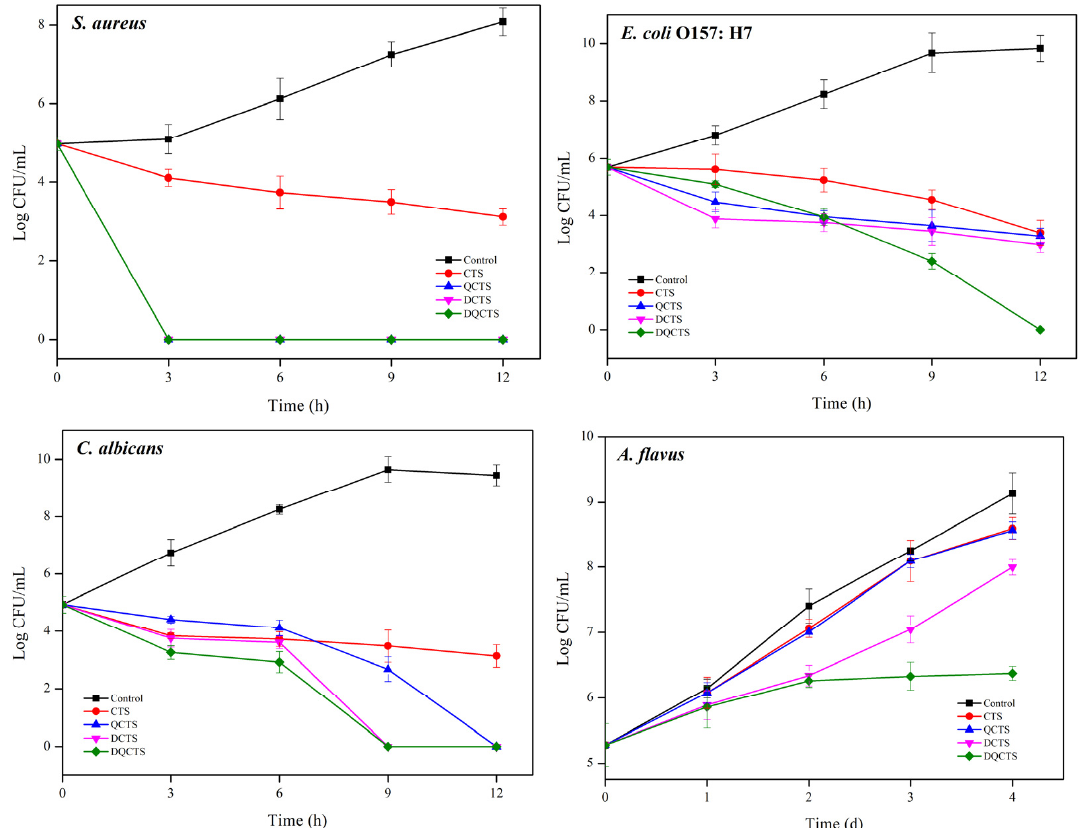
Figure 2. Antimicrobial activity of chitosan compounds against S. aureus (ATCC 13565), E. coli O157:H7 (ATCC 11234), C. albicans (ATCC 18804), and A. flavus (ATCC 22546). CTS: chitosan, QCTS: quaternized chitosan, DCTS: fully deacetylated chitosan, DQCTS: fully deacetylated quaternized chitosan.